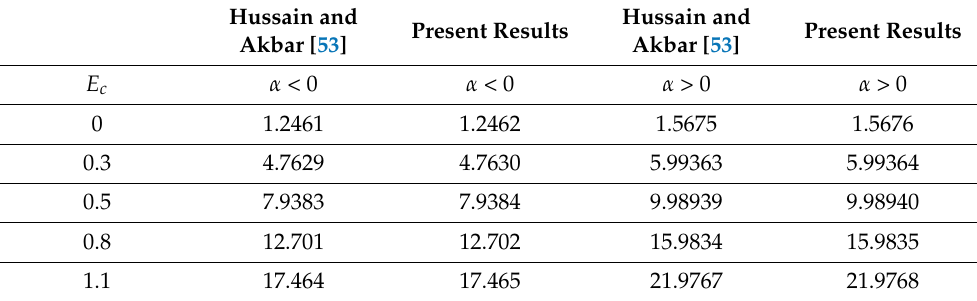
Table 7. Comparison of the upper disk’s flow of heat transfer rate for fixed values of Re = 0, Pr = 2.92, M =